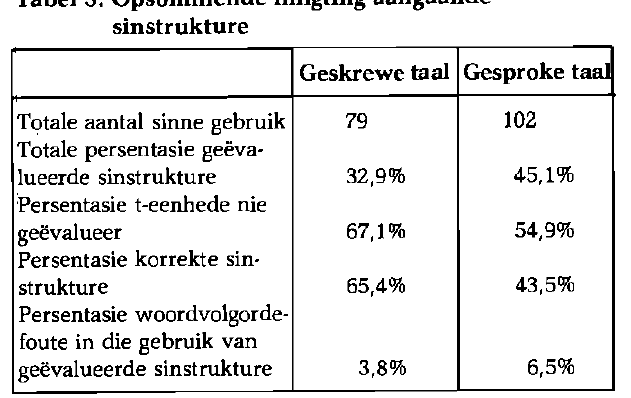
Tabel 3: Opsommende inligting aangaande sinstrukture Geskrewe taal Gesproke taal